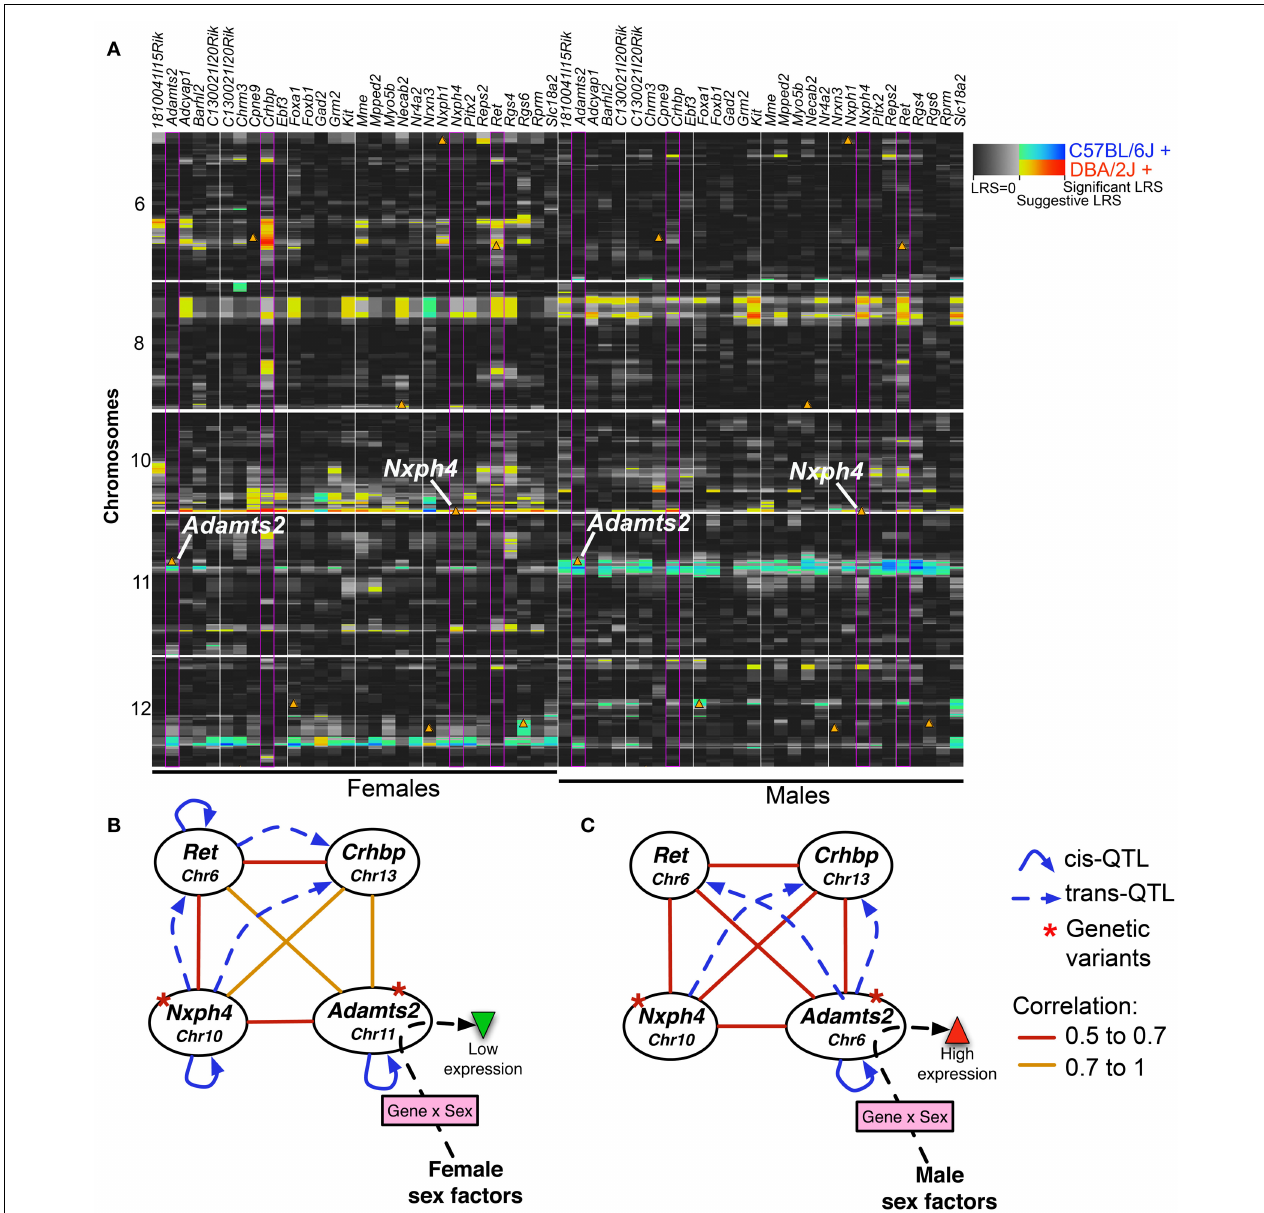
transcripts (highlighted by purple borders in heat map) were used to illustrate a potential model of gene expression regulation in females (B) and males (C) . The four transcripts form a consistent coexpression network in both sexes. However, depending on sex effect, the focal eQTL with trans -effect on Ret and Crhbp shifts from Nxph4 in females to Adamts2 in males.This depicts Adamts2 , which has higher expression in males, as a point of sex-by-gene interaction. Solid arrows represent cis -QTLs and dashed arrows represent trans -QTLs; straight lines show Pearson product correlations.